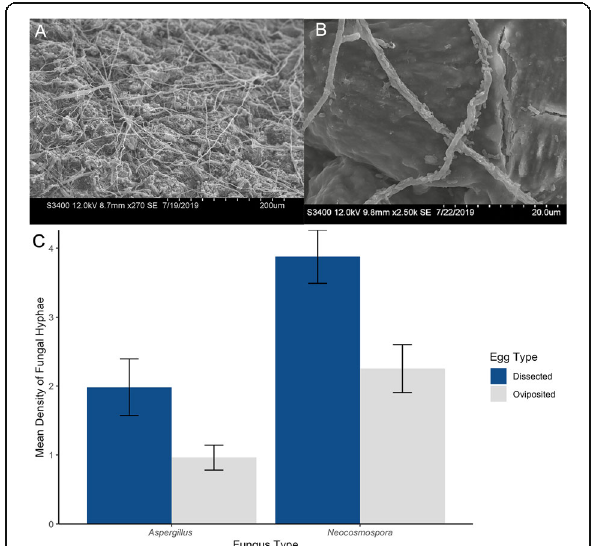
Fig. 7 A Hyphal attachment of Aspergillus protuberus on an eggshell of S. virgatus at 270X magnification. B At 2.5 k magnification, we find hyphae covered in rod-shaped bacteria that are roughly 2 μ m in length. C Mean (± SE) density of fungal hyphae (per 22,800 μ m 2 ) on dissected and oviposited S. virgatus eggs exposed to the fungal species A. protuberus and Neocosmospora rubicola . Fungal hyphae were significantly more dense on dissected eggs than oviposited eggs, for both A. protuberus ( p = 0.012) and N. rubicola ( p =